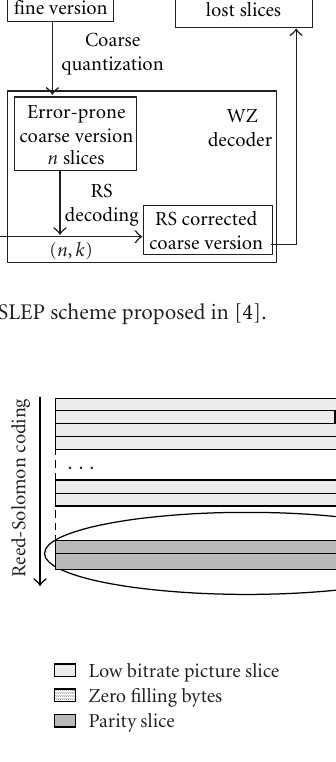
Figure 2: Reed-Solomon encoding across